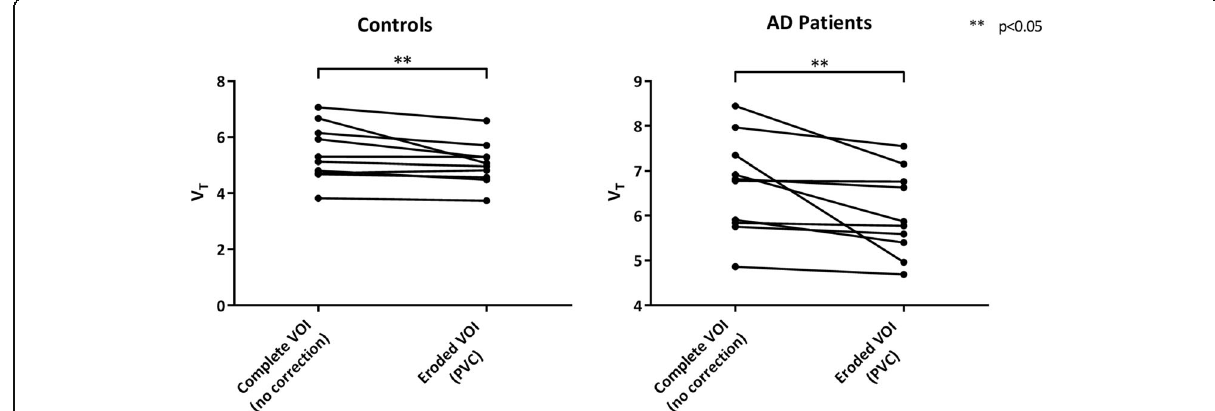
Fig. 3 Spaghetti plots of hippocampus V T before and after using both PVC and an eroded hippocampal VOI within controls (left) and probable AD patients